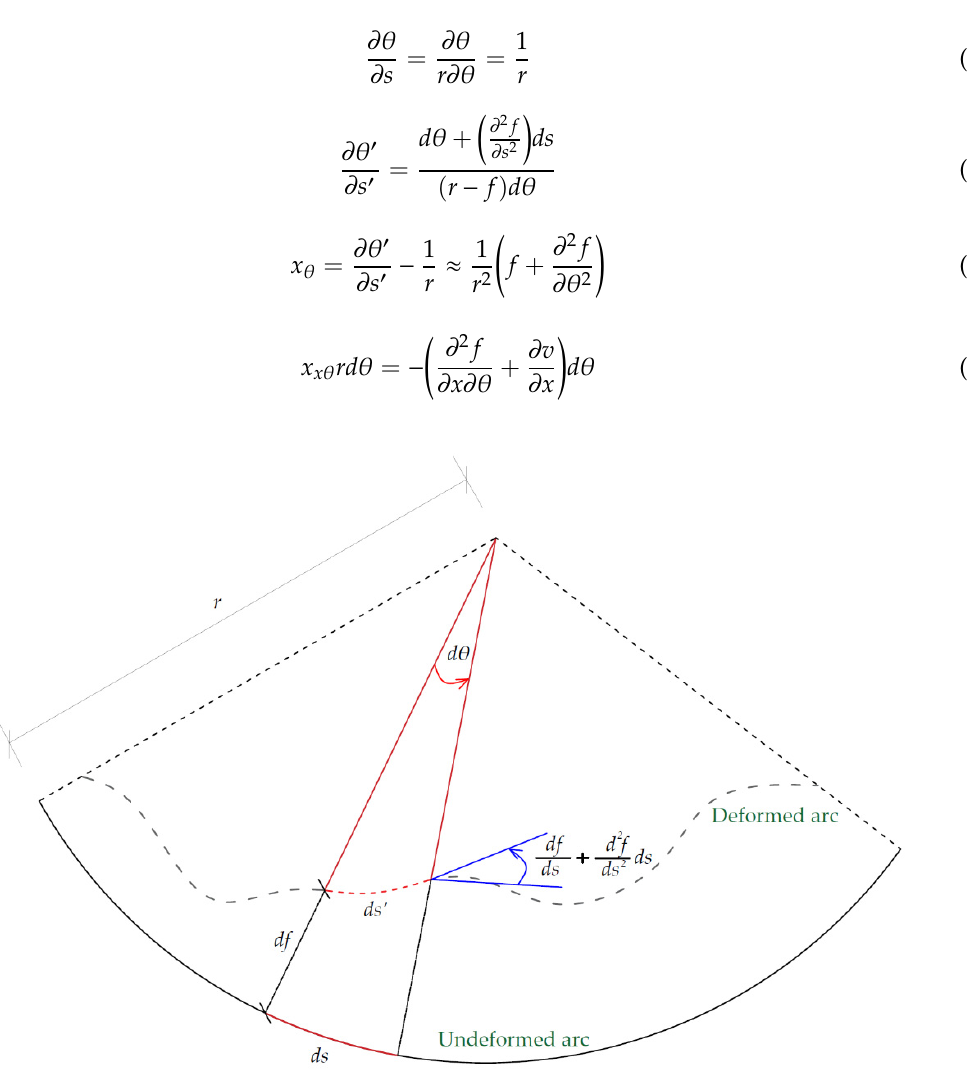
Figure 4. Assumed circumferential shell element deformation.